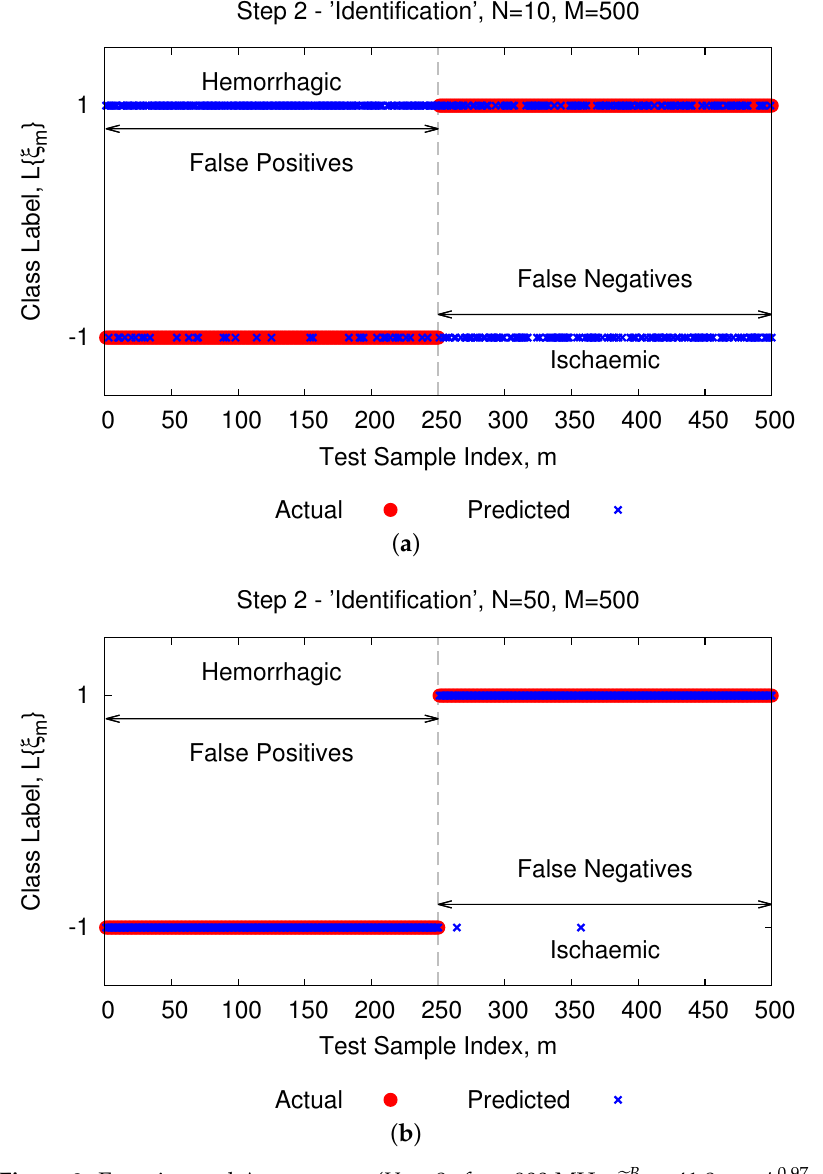
, (cid:101) ε S I = 32.04 ε 0 − 2 π f 0